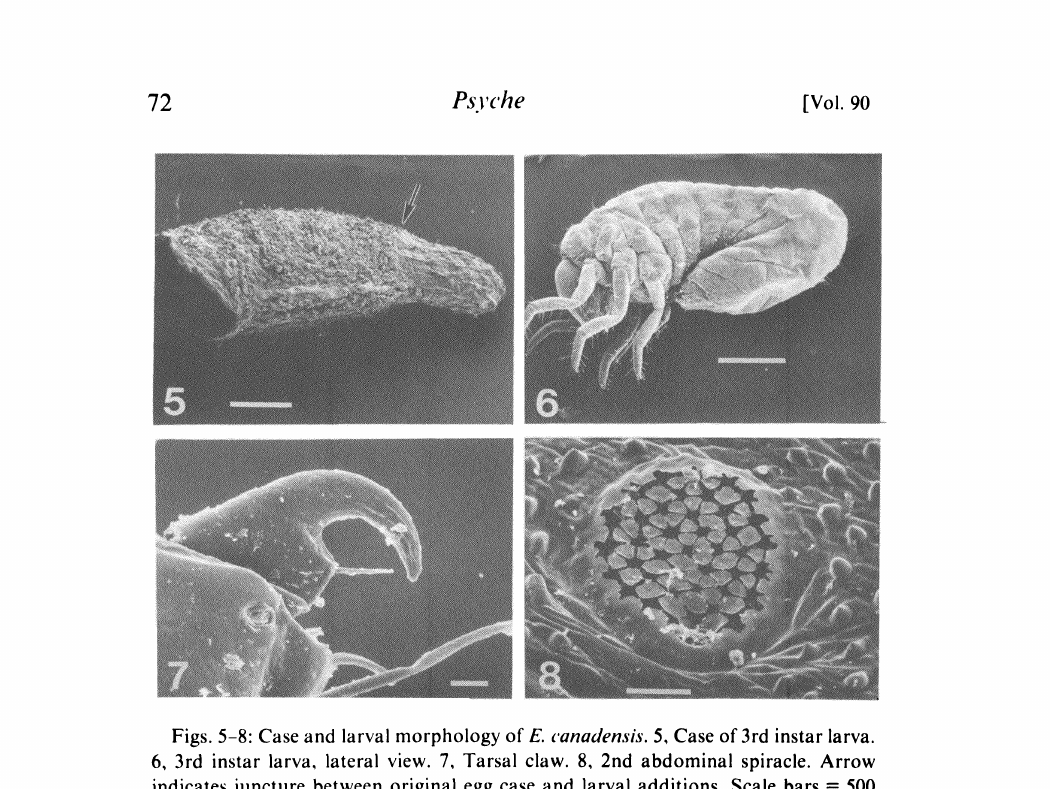
Figs. 5-8: Case and larval morphology of E. canadensis. 5, Case of 3rd instar larva. 6, 3rd instar larva, lateral view. 7, Tarsal claw. 8, 2nd abdominal spiracle. Arrow indicates juncture between original egg case and larval additions. Scale bars 500 (Figs. 5-6) or 10 (Figs. 7-8)